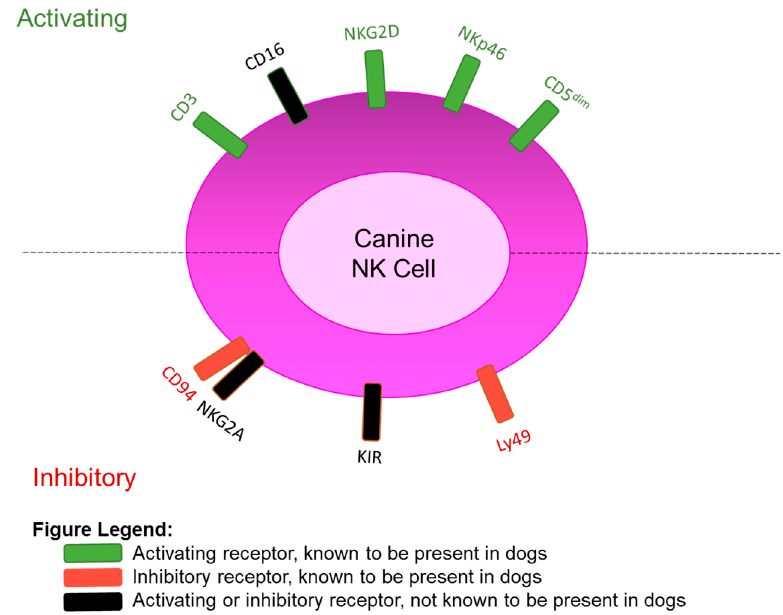
Figure 1. Phenotypic Surface Markers of Canine NK Cells based on Current Evidence.